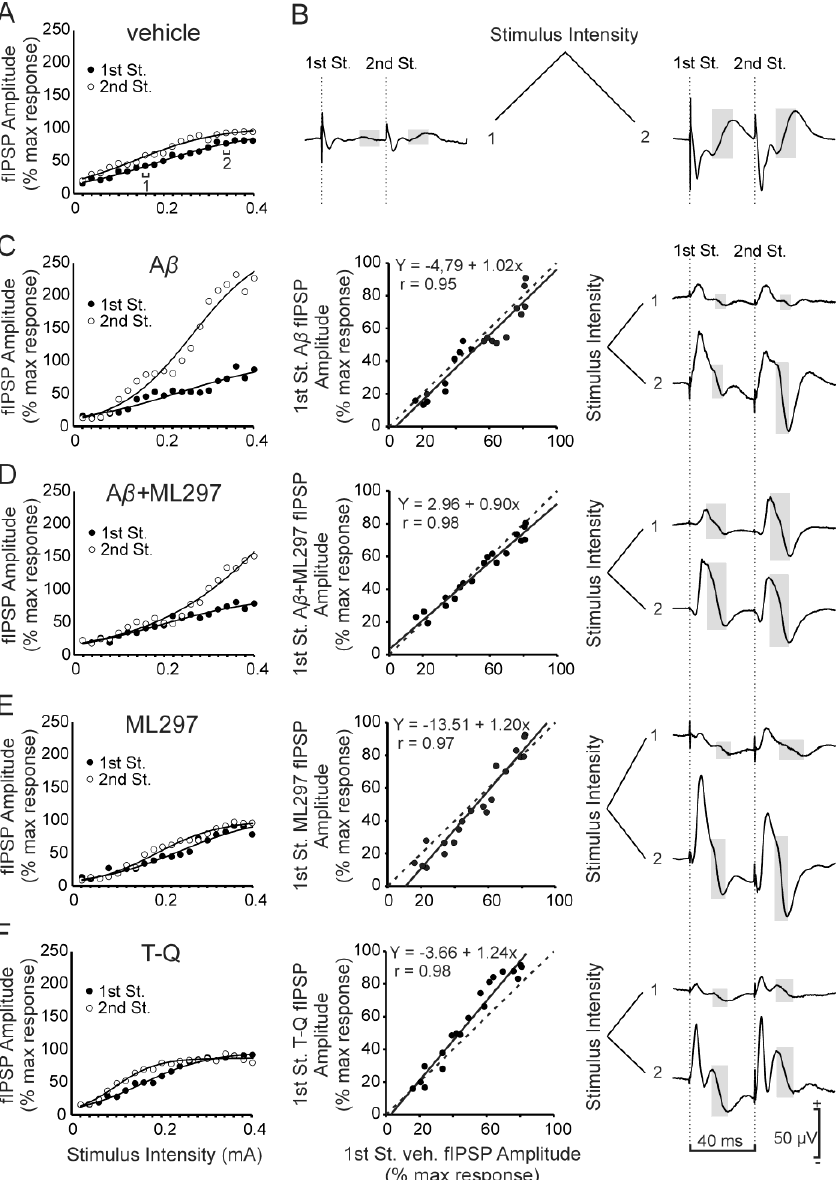
Figure 2. I/O curves for the GABA A -receptor-dependent inhibitory potential. ( A ) and left panel of ( C – F ), Relationship between the intensity (mA) of pairs of stimuli (40 ms interval between stimuli) applied to the Schaffer collaterals and the amplitude of the ionotropic GABAergic fIPSPs evoked in the CA1 region, corresponding to the first (black circles) and second (white circles) pulse. For each intensity of stimulation, circles represent the average of the response for all the animals of each experimental group. To facilitate the interpretation of the data, error bars have been omitted and the best sigmoid fit to the data for each group of animals has been illustrated (r ≥ 0.98 in all cases except for the 1st pulse of the A β group, r = 0.955; p < 0.001). Note the increase in the fIPSP amplitude caused by the 2nd stimulus in animals injected with A β ( C ) and how the drug ML297 was able to restore this effect to control (vehicle) levels. Animals injected with T-Q ( F ) did not present an increased amplitude in the 2nd pulse. Center panel of ( C – F ), Scatter plots and linear fits (continuous black lines) illustrating